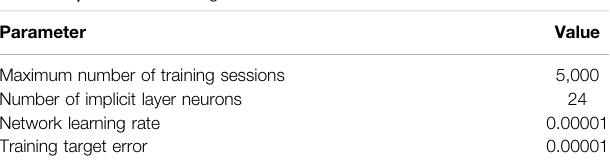
TABLE 2 | Parameter setting of neural